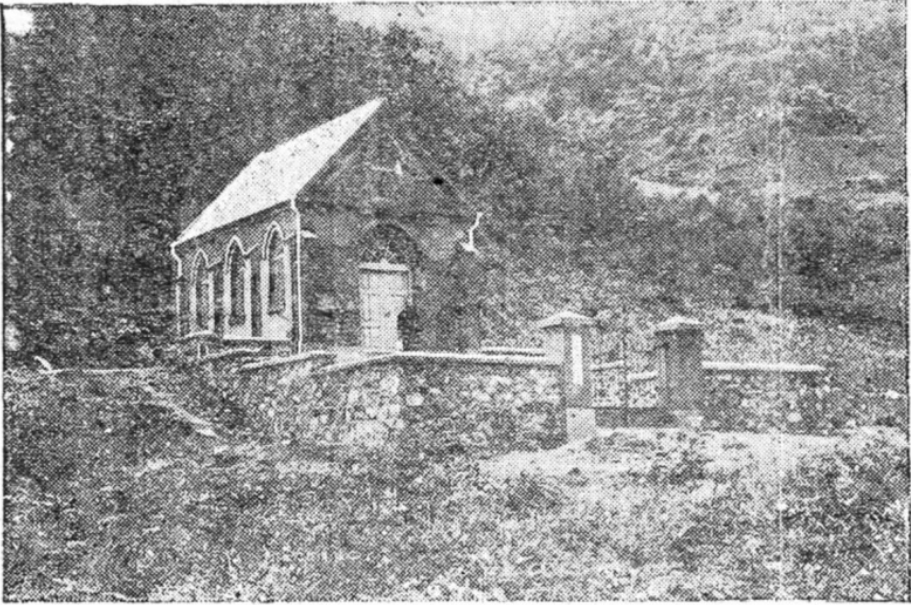
Figure 13. Image dated 1928 [source: The Dong-A Ilbo , 5 October 1928]. Fourth, the grave of Father Kim Dae-Geon has changed. The grave and the other graves in 1928 were made with concrete (Kang 2016, pp. 570–71). From the photos in 1965, 1970, and 1976, a cross on the concrete coffin shape can be seen (see Figure 15). However, a stone coffin replaced the concrete coffin in 1984 and information that the grave is Father Kim Dae-Geon’s is inscribed on the black slab along with important dates (born: 21 August 1821; ordained: 17 August 1845; martyred: 16 September 1846; beatified: 5 July 1925; canonized: 6 May 1984) (see Figure